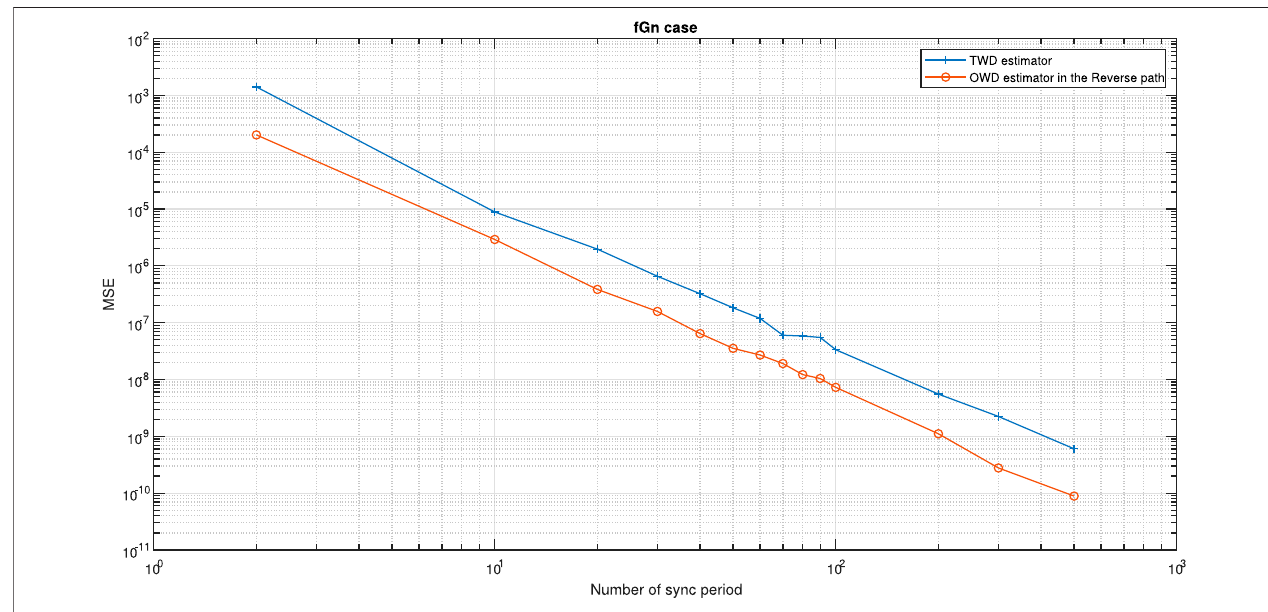
FIGURE 4 | Test case b of Theorem 8. Performance (MSE) comparison between the OWD clock skew estimator in the Reverse path ( Eq. 62 ) and the TWD clock skew estimator ( Eq. 60 ). The PDV is an fGn process. α = 50 ppm , Q = 5 ms , T syn (cid:2) 15 . 6 ms ( 64 packet